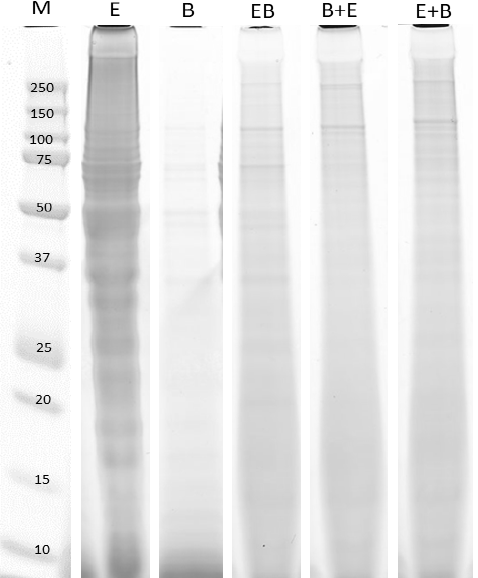
Figure 4. The resulting SDS-PAGE gels of hydrolysates from mixed and single proteases after inactivation. The figure shows a collage of lanes cut from one gel. In the left lane, the Mw marker (M) with the size of the Mw standard proteins given (kDa).